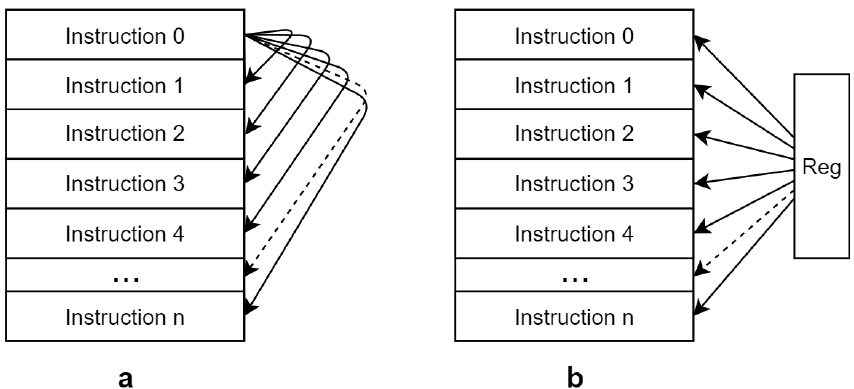
Figure 5. ( a ) Each multi-cycle instruction in an entry of depth N is compared with each other. ( b ) The instruction outside the entry only needs to be compared N times.